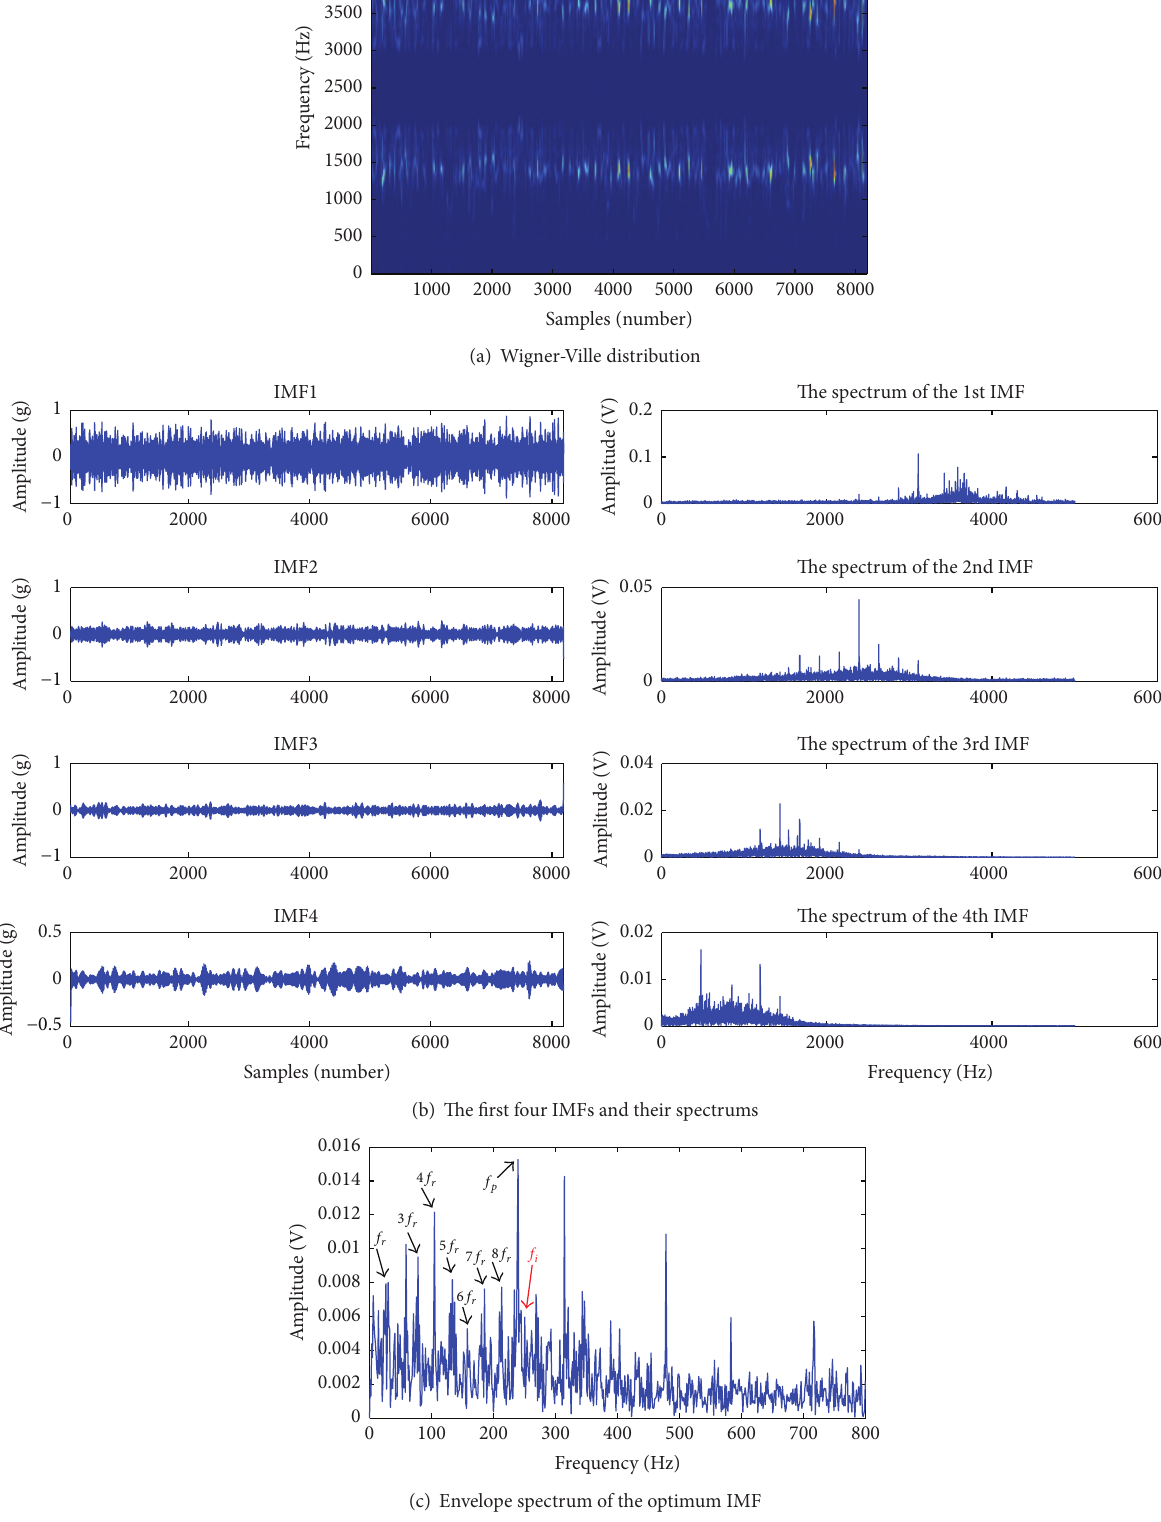
(c) Envelope spectrum of the optimum IMF Figure 3: Bearing inner race fault diagnosis by envelope analysis for optimum